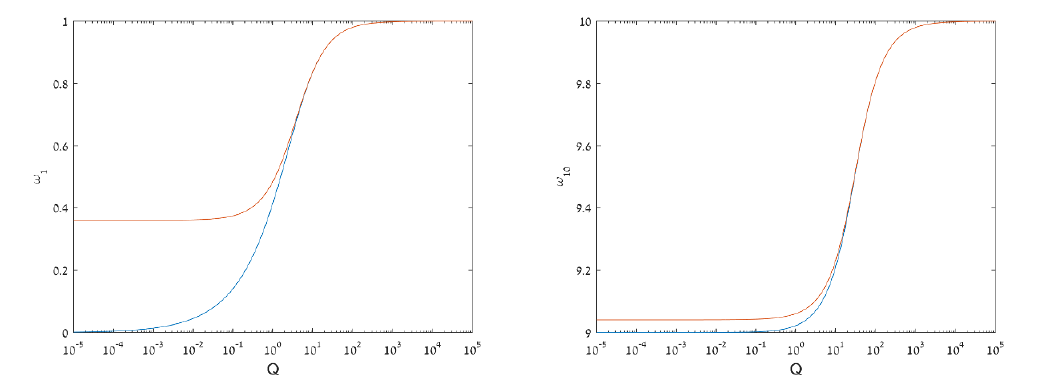
Figure 4 . The exact solution of eq. (4.106) for y n ( Q ) (blue) versus the approximate solution of eq. (4.108) (red), plotted for n = 1 and 100. For Q (cid:29) 1 the approximation is valid for any n . As n increases the approximation is improving for smaller Q as